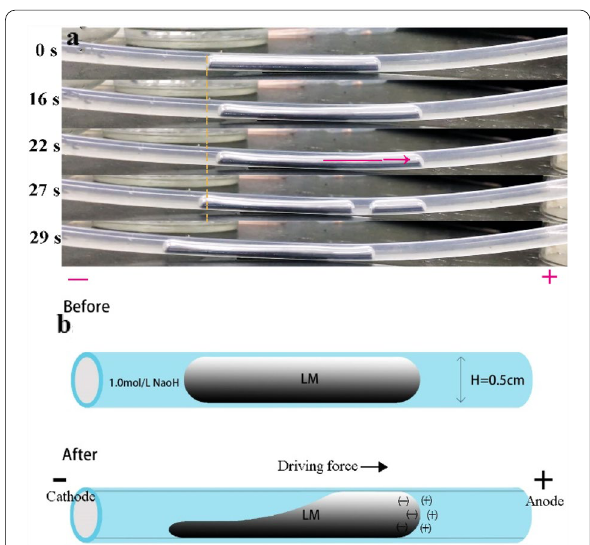
Figure 1 a Deformation peristaltic behavior of short liquid metal column in a closed pipeline under the voltage, b Deformation behavior of liquid metal column in confining